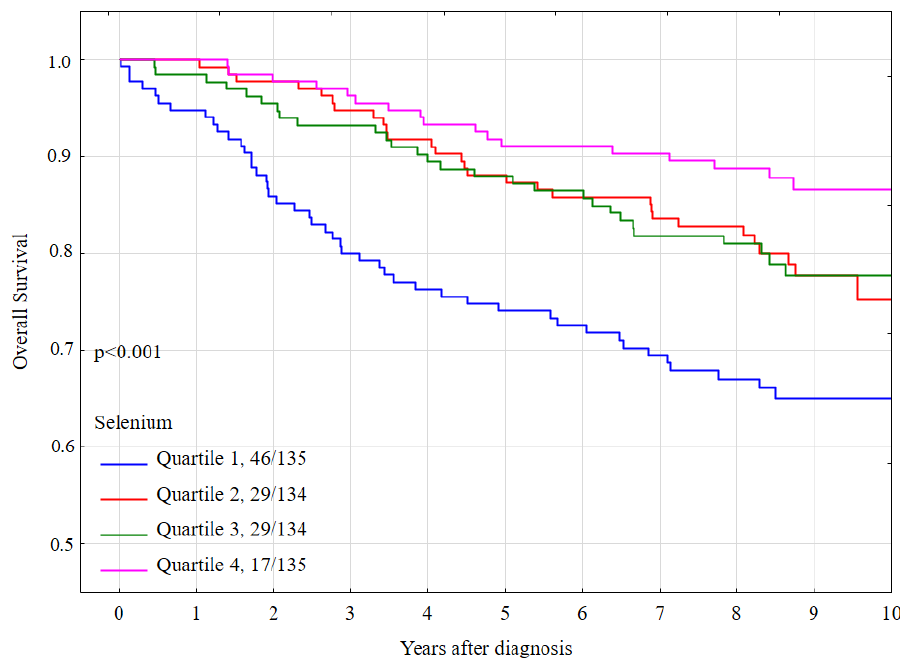
Figure 1. Ten-year all-cause mortality by quartile of serum selenium levels, all women. The 10-year breast cancer specific survival rates were lower for women with a selenium level in quartile 1 (76.7%) than for women in the other three quartiles (84.2% for quartile 2, 83.4% for quartile 3, 87.9 for quartile 4) and the difference was statistically significant ( p -long rank = 0.014) (Table 2). Breast cancer-specific survival by quartile of serum selenium is presented graphically in Figure 2. Compared to women in quartile 4, the univariate hazard ratio (HR) for breast cancer- specific mortality for women in quartile 1 was 2.31 (95% CI 1.24–4.31, p = 0.008). (Table 3). Compared to women in quartile 4, the multivariate hazard ratio (HR) for breast cancer- specific mortality for women in quartile was 1.56 (95% CI 0.72–3.40) and this difference did not reach statistical significance ( p = 0.26) (Table